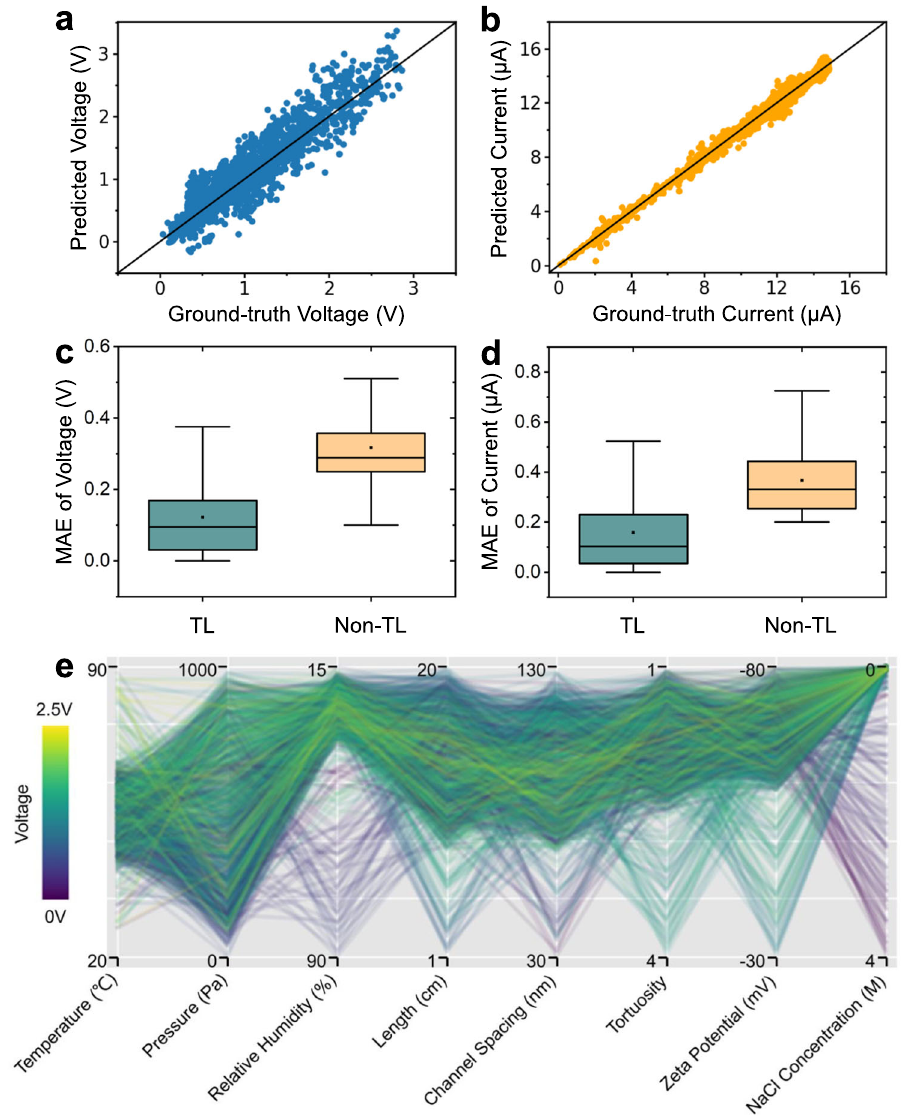
Fig. 5 | The opt-model performance for V oc and I sc predictions. The opt-model predicted a V oc and b I sc versus experimental data (ground truth) of the 2D-WEGs. Each point represents a 2D-WEG instance, where the abscissa value is the V oc / I sc measuredexperimentally, and the ordinate value isthe V oc / I sc predicted by the TL- based opt-model. All points are clustered around the diagonal, indicating that the opt-model is able to make accurate predictions for 2D-WEGs with different para- meters and generation performance. Box plots of the absolute errors of the pre- dictions for c V oc and d I sc by the TL-basedopt-modelversus the absolute errorsof